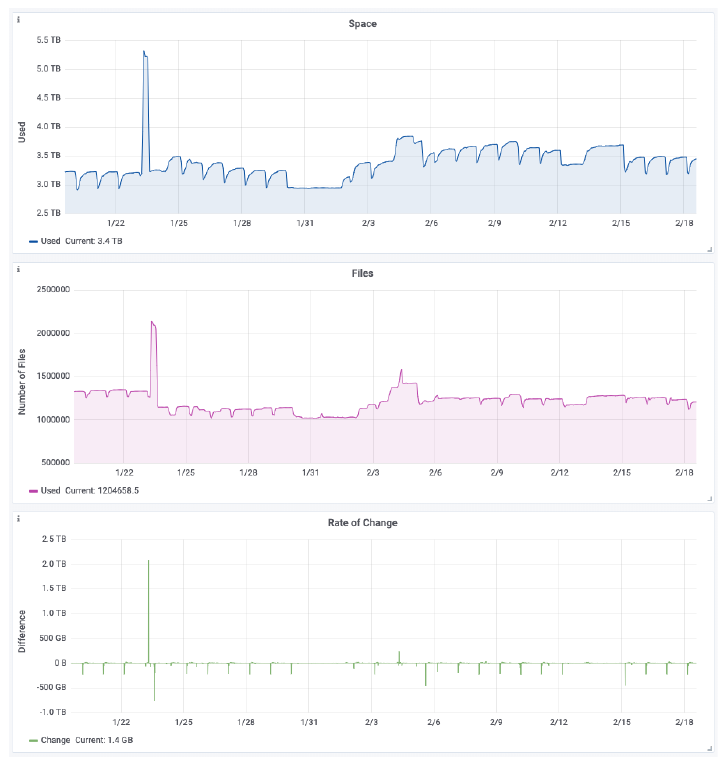
Figure 3. Grafana dashboard showing used files, disk space and rate of change